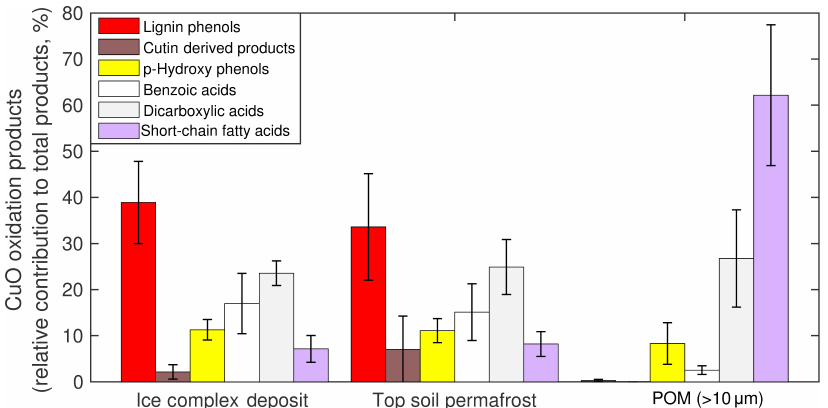
Figure 3. Alkaline CuO fingerprint of top-soil permafrost samples (Tesi et al., 2014), Pleistocene ice complex deposit (Tesi et al., 2014) and POM (>10µm) fraction (this study). The plot displays the relative proportion products yield upon alkaline CuO oxidation. The error bar refers to the natural variability of each dataset.